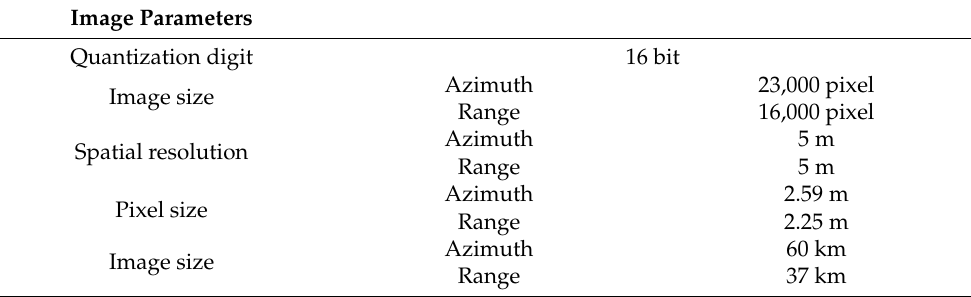
Table 3. Specification of SLC images.